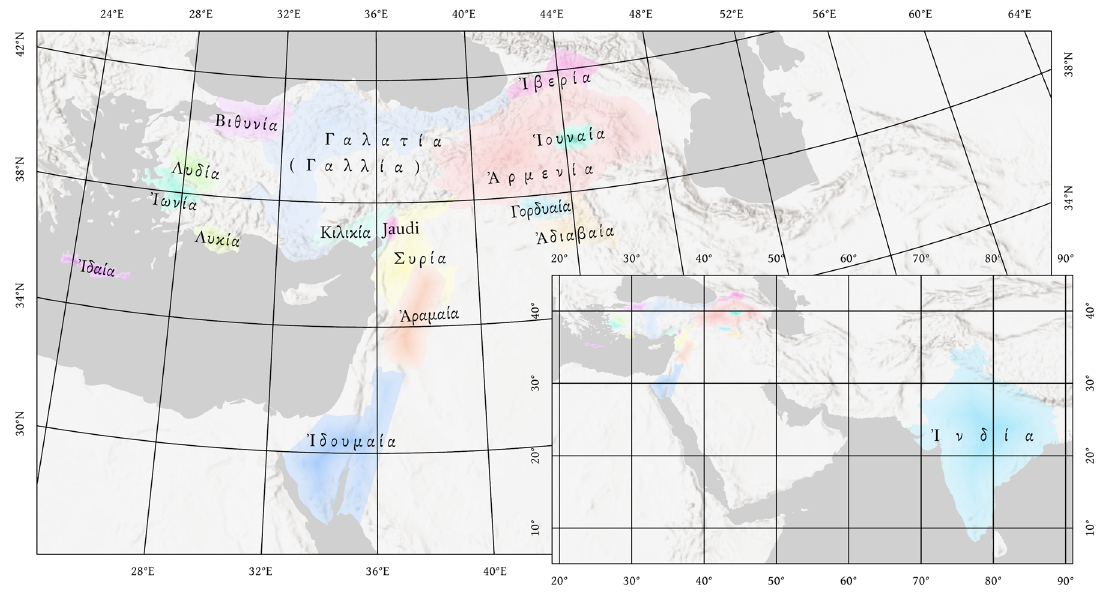
Figure 2: Locations of the conjectural emendations to Ἰ ουδαία which can be found in the Amsterdam Database of New Testament Conjectural Emendation ( ADNTCE )